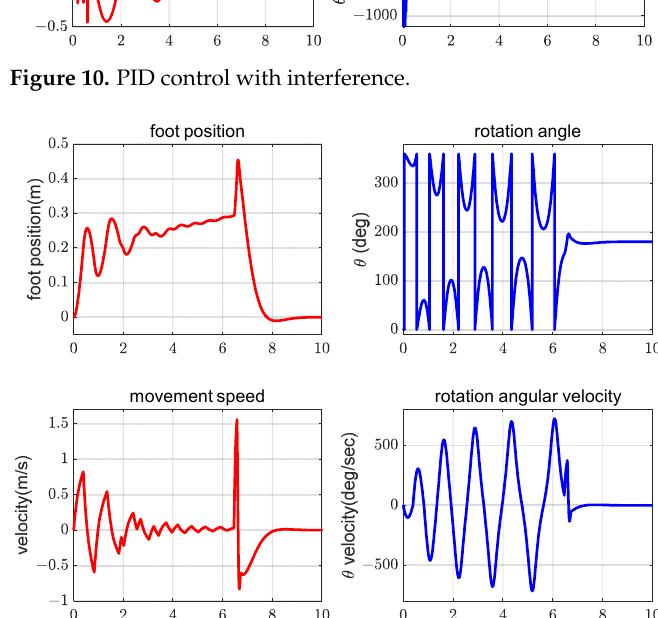
Figure 11. LQR control with interference.